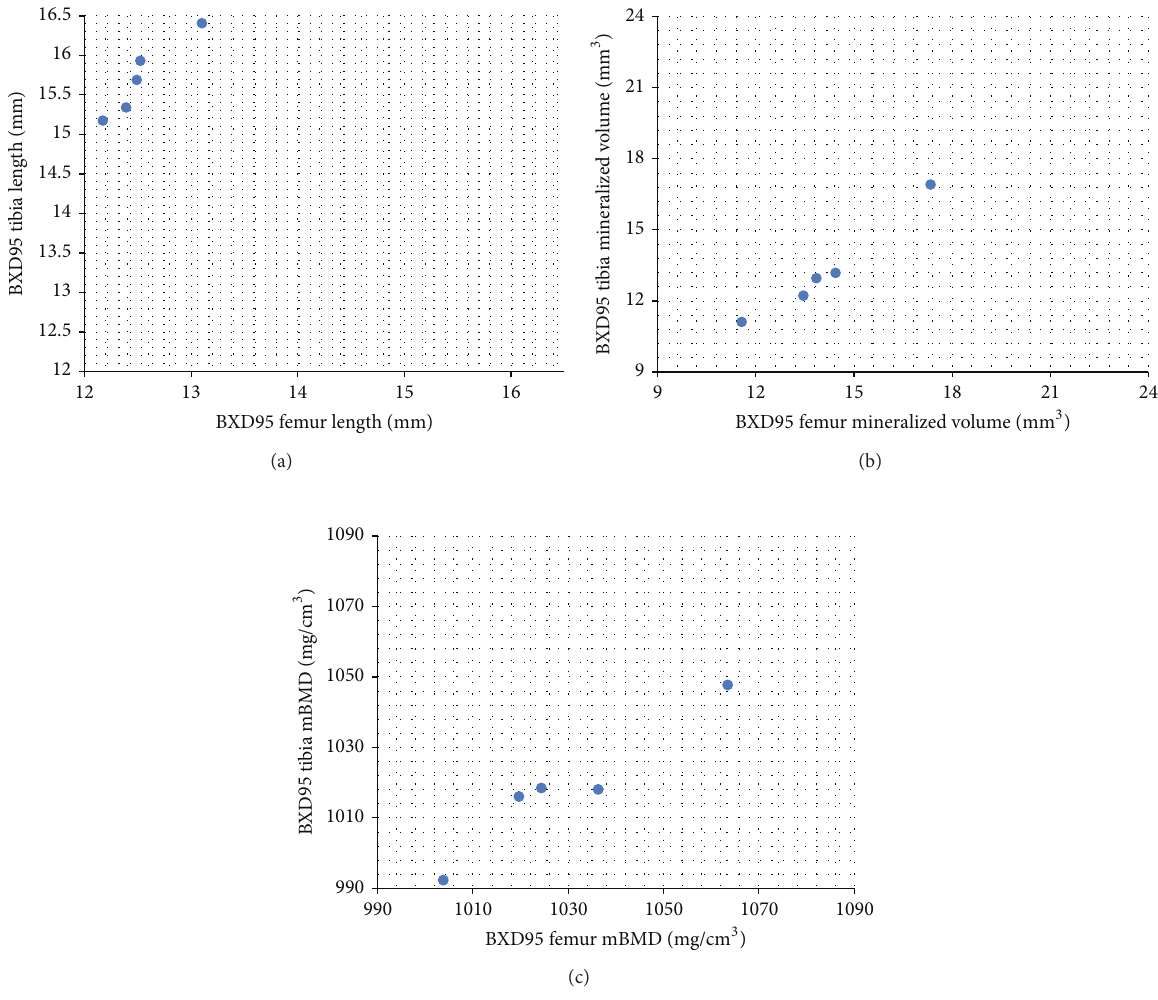
Figure 3: Spearman’s rank correlations in RI Strain BXD95 whole bone profile showed a variety of associations between femur and tibia. (a) 𝑟 = 1.0 , 𝑃 < 0.0001 ; (b) 𝑟 = 1.0 , 𝑃 < 0.0001 ; (c) 𝑟 = 0.9 , 𝑃 = 0.04